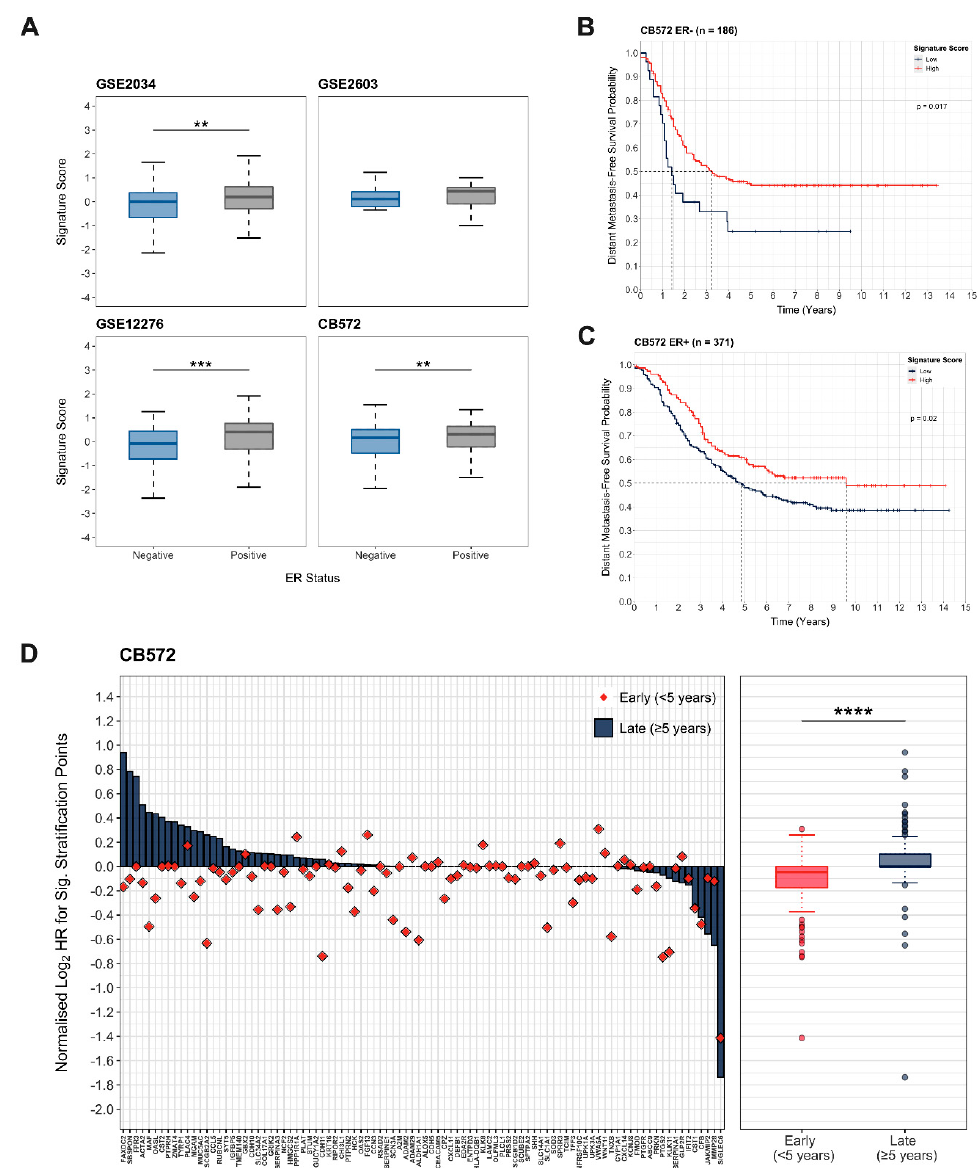
Figure 3. Quiescence-Associated Genes are Correlated with Late Metastatic Recurrence. ( A ) Com- parison of integrated expression scores for quiescence-associated genes in patients with oestrogen receptor-positive (ER+) and oestrogen receptor-negative (ER − ) tumours within data sets (GSE2034, GSE2603 and GSE12276) comprising the CB572 cohort (Wilcoxon rank-sum test, ** = p ≤ 0.01, *** = p ≤ 0.001). ( B ) Distant metastasis-free survival probability over time in patients within the CB572 co- hort with ER − tumours integrated signature scores for expression of quiescence-associated signature genes (n = 186, log-rank test). ( C ) Distant metastasis-free survival probability over time in patients within the CB572 cohort with ER+ tumours stratified by integrated signature scores for expression of quiescence-associated signature genes (n = 371, log-rank test). ( D ) Cox proportional hazards sur- vival analysis of the quiescence-associated signature genes represented in primary breast tumours of patients in the CB572 composite data set (n = 572). Patients were stratified at all possible cut-off points (n − 1) for all signature genes. For each gene, the log 2 -transformed cumulative hazard ratio for all cut-off points significantly ( p ≤ 0.05) associated with late distant metastatic recurrence and early distant metastatic recurrence (<5 and ≥ 5 years after primary tumour diagnosis, respectively) nor- malised to total possible cut-off points are shown. Quiescence-associated signature genes were sig- nificantly associated with late metastatic recurrence (Wilcoxon rank-sum test, **** = p ≤ 0.0001).